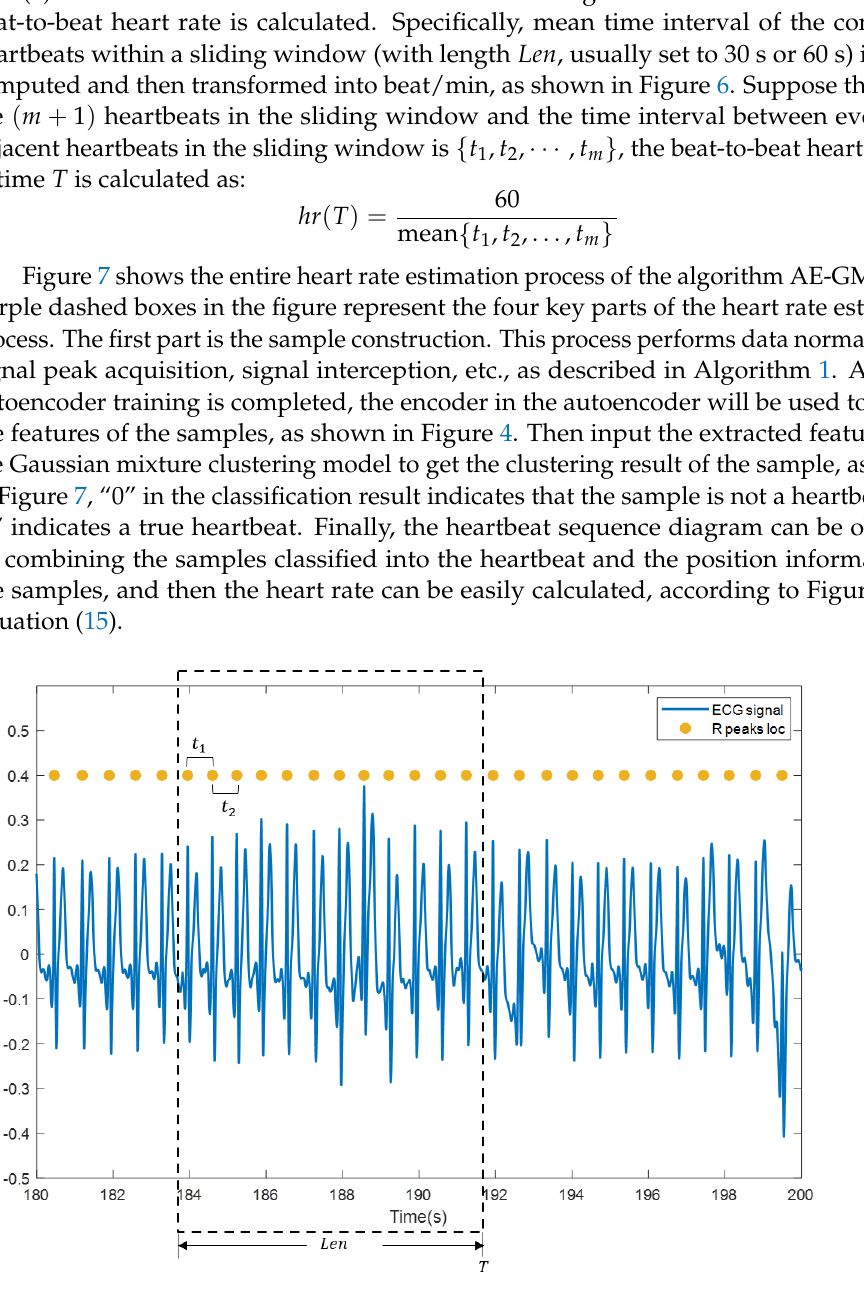
Figure 6. Calculation of beat-to-beat heart rate. The blue curve is the ECG signal, and the yellow solid dot is the reference position of the R